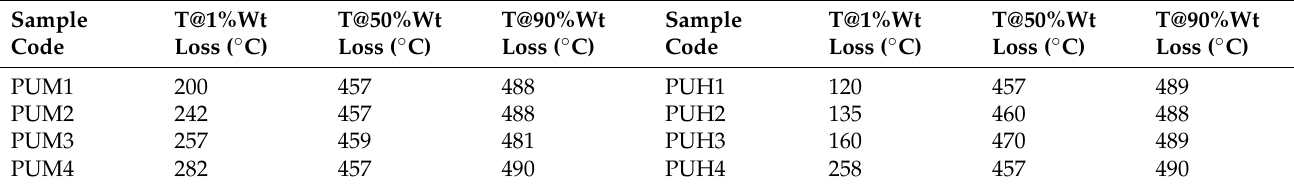
Table 3. Weight loss (%) data of polyurethane (PU) composites obtained by thermalgravimetric analysis (TGA). Sample